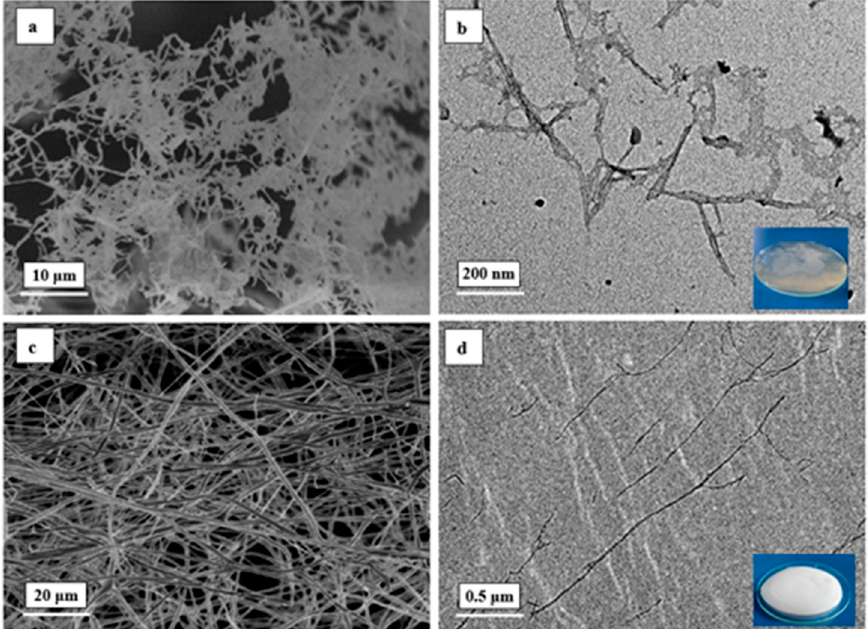
Figure 2. Microscopic morphology of nanocellulose: ( a ) FE-SEM image of NCC, ( b ) TEM image of NCC, ( c ) FE-SEM image of CNF and ( d ) TEM image of CNF.